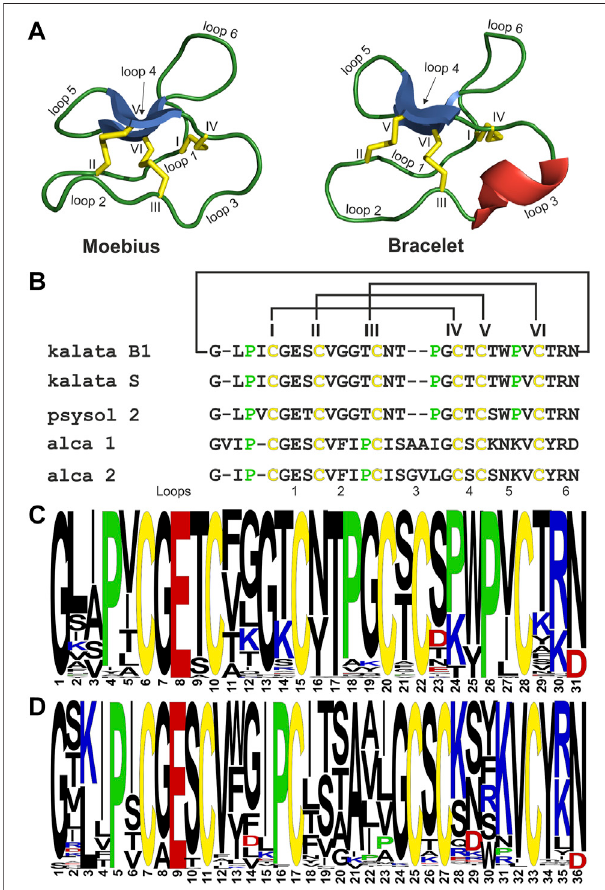
FIGURE 7 | Sequence comparison of POP inhibiting cyclotides. Structural models of archetypical cyclotides kalata B1 ( Moebius type) and cycloviolacin O2 (bracelet type) are illustrated with disul fi de bonds in yellow, β -sheets in blue and α -helixes in red. Loops are labelled from 1-6 and cysteinesarelabelledinromanlettersfromItoVI (A) .Asequencealignmentof the POP inhibitory cyclotides kalata B1, psysol 2, alca 1 and alca 2 as well as kalataSisshown.Thealignmentstartswiththe fi rstaminoacidsofthemature domain. The conserved cysteines are indicated in yellow and proline residues in green. The cyclic backbone as well as the cystine knot are indicated with connecting lines. The cysteines are labelled in roman letters from I to VI (B) . Frequency plots of amino acid sequences of Moebius type (C) and bracelet type (D) cyclotides from the Violaceae family areshown. Atotal of87 Moebius type and 189 bracelet type representative Violaceae cyclotide sequences were included for preparing the sequence logos. The conserved cysteine residues are presented in yellow, acidic in red, basic residues in blue and prolinesingreen.Thelogostartswiththe fi rstaminoacidofthemature( ‘ core ’ ) domain within the cyclotide precursor